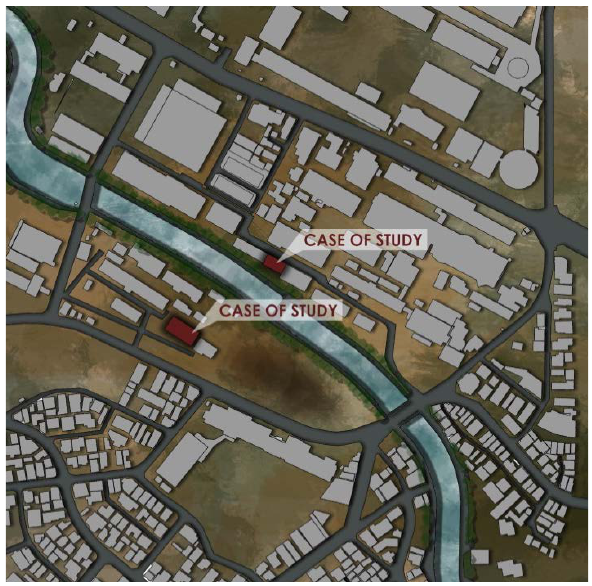
Figure 5: Kaga park area and cases of